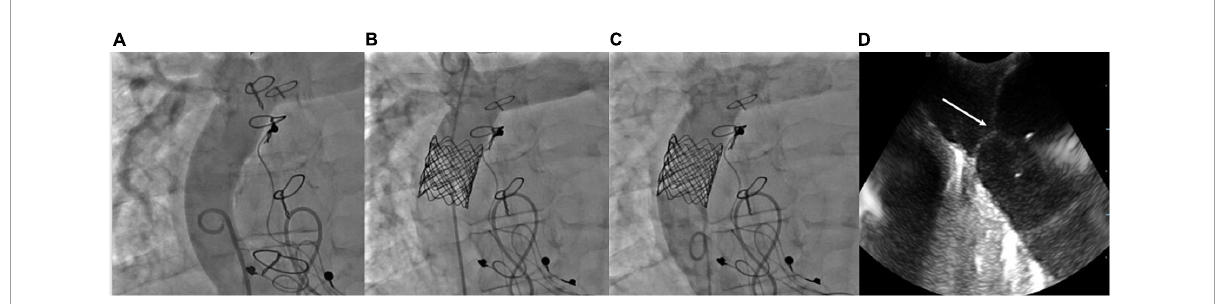
FIGURE11 Melody valve implantation in a patient with a Fontan circulation. (A) Basal angiogram of the extracardiac conduit; (B) angiogram showing a competent Melody valve; (C) angiogram showing good forward flow between inferior vena cava and pulmonary arteries; (D) intra-cardiac echography 1 after implantation, showing competent Melody valve and perfect leaflets coaptation (white